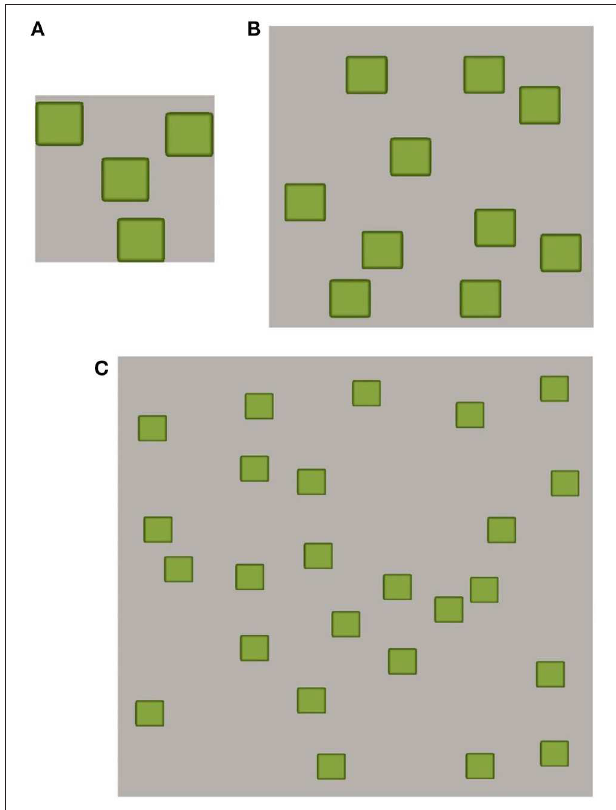
FIGURE 3 | A schematic representation of possible fragmentation patterns of green areas (parks, garden) in expanding urban areas. Examples range from the pattern of (A) , where fragmentation is limited and large green areas almost come into contact, to the pattern of (C) where, as indicated in the text, increasing fragmentation and decreasing connectivity may result in alteration or reduction of ecosystem services offered by green areas (see also Table 1 ). (B) Represents an intermediate